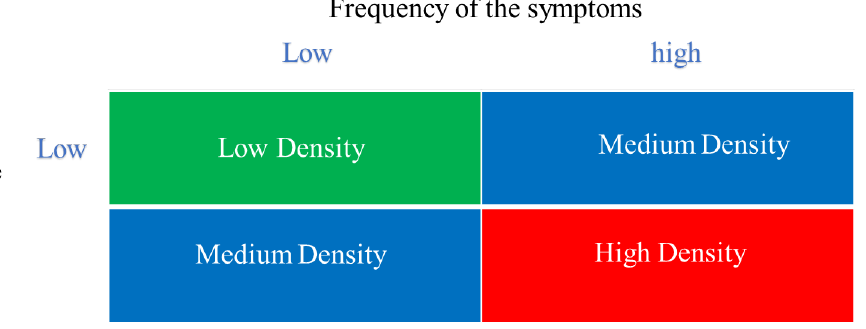
Figure 5. Justification for the use of Density of Burnout in future research.